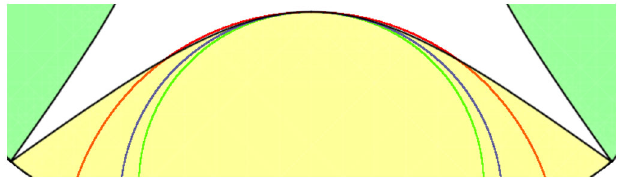
FIG. 6. The football electrode with superposed, the circular arc of radius 1.15 times the aperture radius (green), 4 =(cid:3) ð 1 : 27 Þ times the aperture radius (blue), and 1.65 times the aperture radius (red).